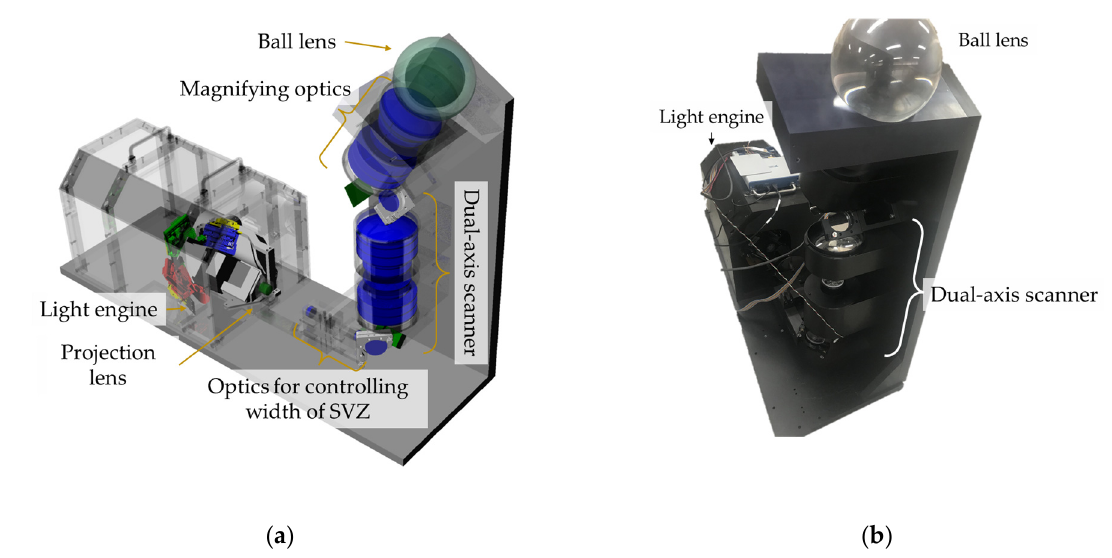
Figure 12. Proposed full-parallax multiview display with spherical symmetry. ( a ) Structure and ( b ) prototype implementation of the proposed system. Table 2. Specifications of optical scanners in the proposed full-parallax multiview display.